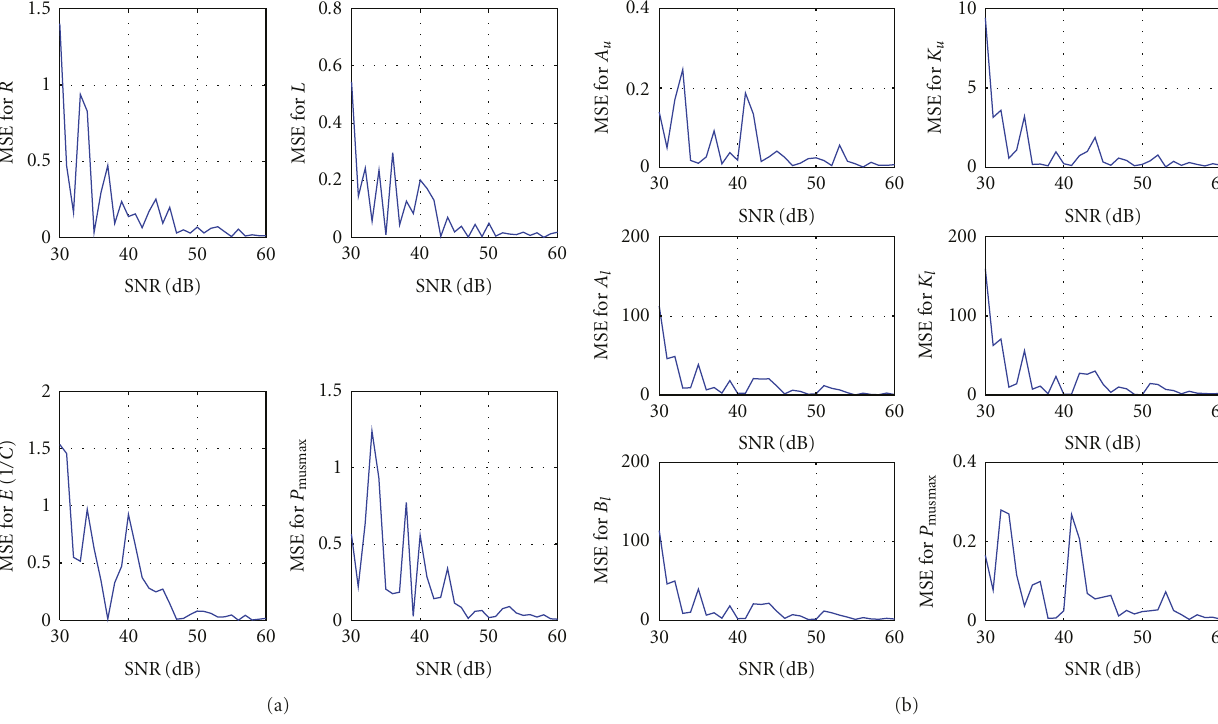
Figure 3: (a) Mean Squared Error (MSE) versus SNR for linear RIC model parameter estimation produced by artificial signals. (b) Mean Squared Error (MSE) versus SNR for nonlinear model parameter estimation produced by artificial